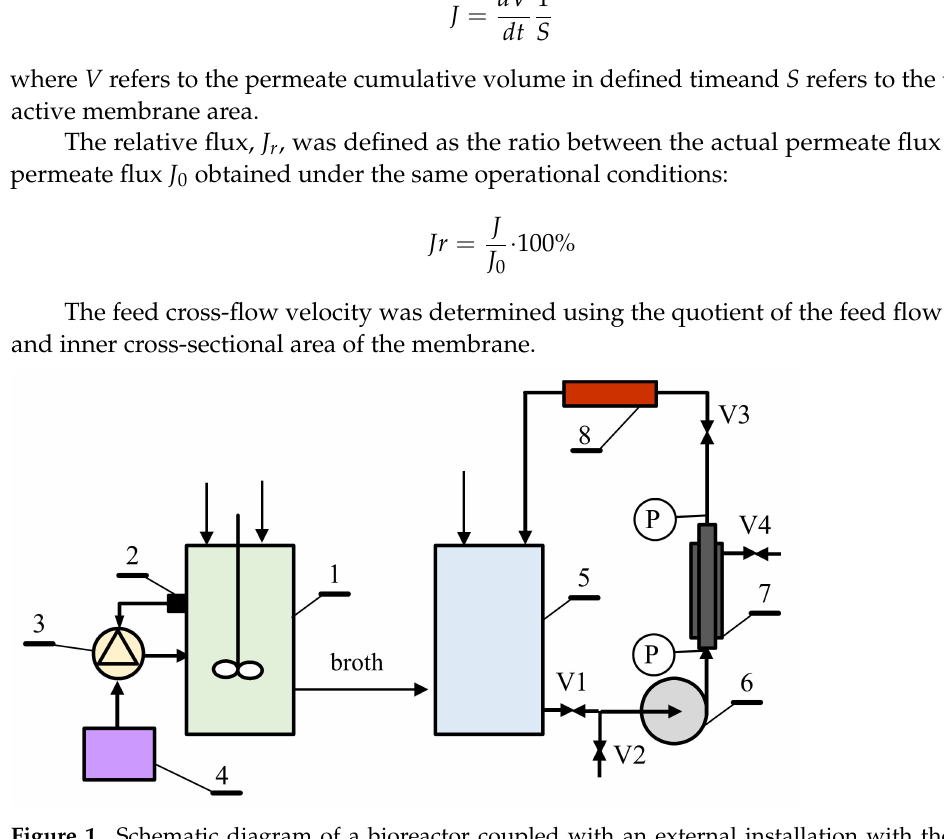
Figure 1. Schematic diagram of a bioreactor coupled with an external installation with the UF membrane module. 1—bioreactor, 2—pH sensor, 3—NaOH dosing unit, 4—NaOH tank, 5—feed